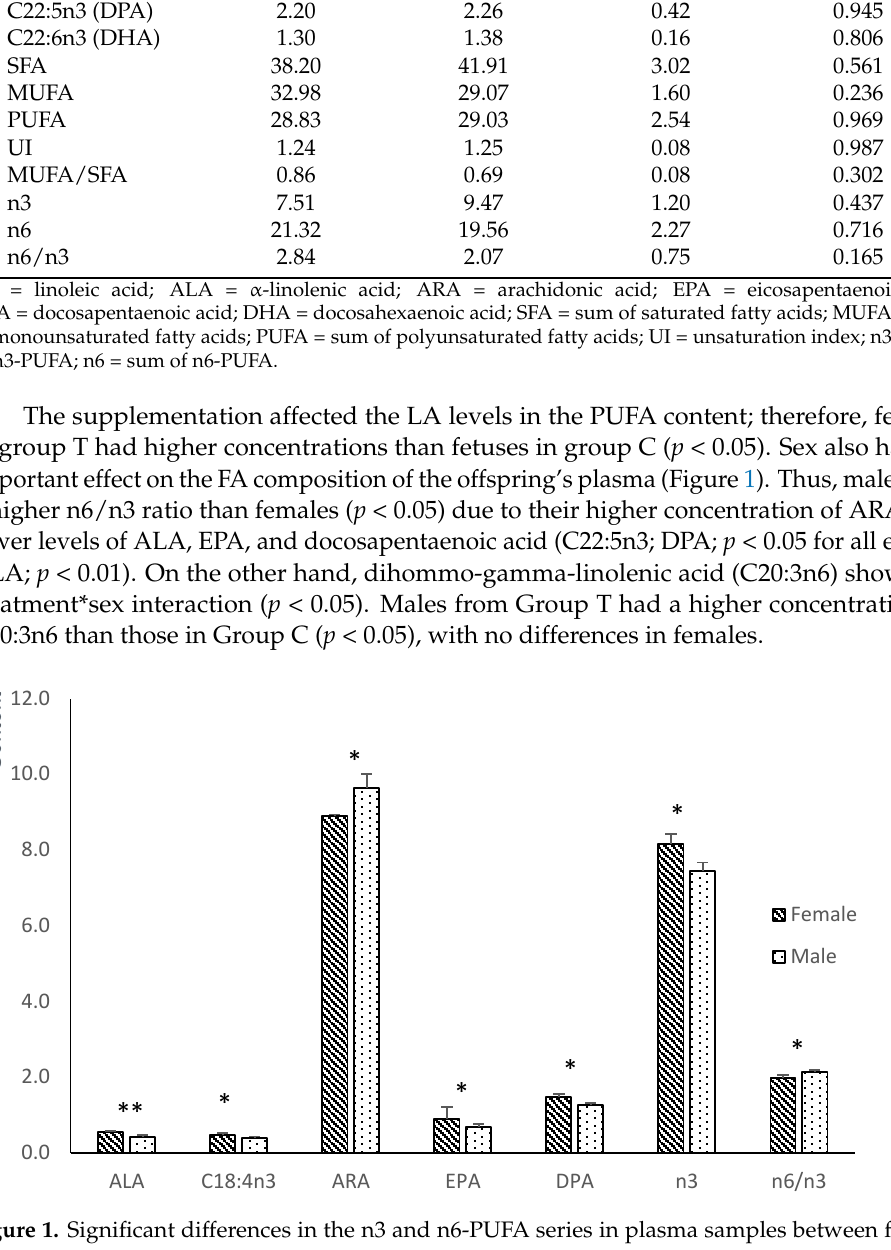
Figure 1. Significant differences in the n3 and n6-PUFA series in plasma samples between female and male fetuses obtained at 100 days of gestation born from control gilts or from gilts treated with hydroxytyrosol and linseed oil from day 35 to day 100 of gestation. ALA = α -linolenic acid; ARA = arachidonic acid; EPA = eicosapentaenoic acid; DPA = docosapentaenoic acid; n3 = total sum of n3-Polyunsaturated fatty acid; n6 = total sum of n6-Polyunsaturated fatty acid. * p < 0.05; ** p < 0.01.